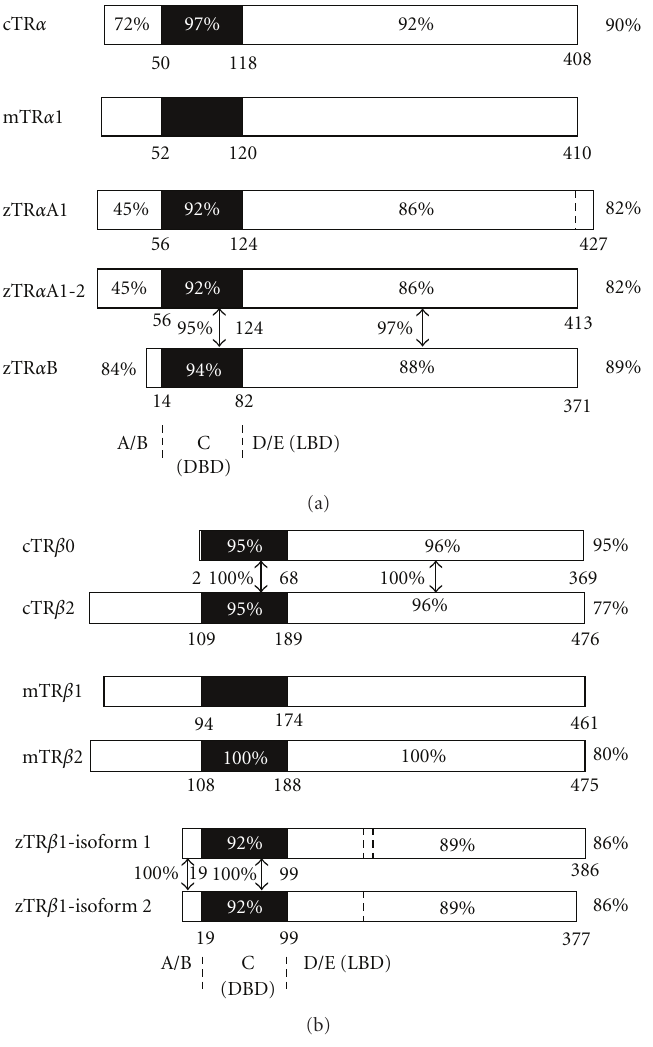
Figure 1: Comparison of mouse (m), chicken (c), and zebrafish (z) TR isoforms. (a) TR α variants and (b) TR β variants. Truncated TR isoforms that do not bind T 3 are not included, nor are the TR β 3 variants that have only been found in rats. Numbering of amino acids is represented under each bar. Percentages within the bars are identities of that domain with the homologous domain of mTR α 1 or mTR β 1, respectively. Percentages right of the bars give the overall similarity of the entire protein with the canonical mouse homolog. Percentages in between bars show the similarity between the respective domains. A/B: A and B domain; C (DBD): C domain or DNA-binding domain; D/E (LBD): D and E domain or ligand-binding domain. The dotted line in the D/E domain of zTR α A1 marks the first of the 14 additional carboxy-terminal amino acids not found in the other TRs. The dotted lines in the D/E domain of zTR β 1 isoform 1 delineate a 9-amino-acid insert that is missing in the equivalent location in zTR β 1 isoform 2 (also indicated with a dotted line). Comparisons were based on the following UniProtKB sequences: mTR α 1 (P63058-2), mTR β 1 (P37242-1), mTR β 2 (P37242-2), cTR α 1 (P04625), cTR β 0 (P68306), cTR β